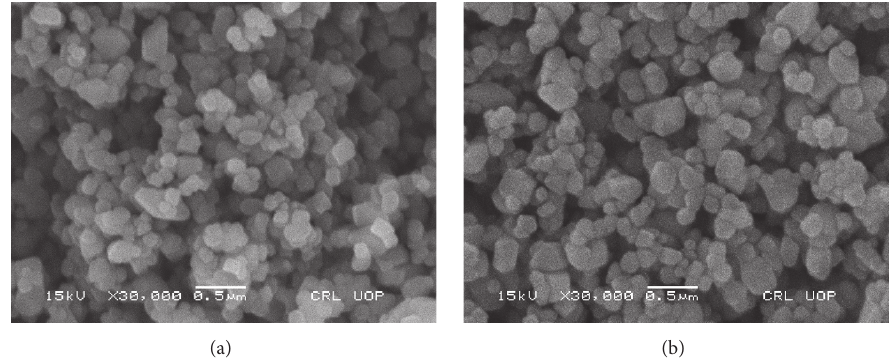
Figure 2: SEM images of (a) 0.1% Pt/TiO 2 and (b) 0.1% Pd/TiO 2 used as a photocatalyst for liquid phase oxidation of toluene.